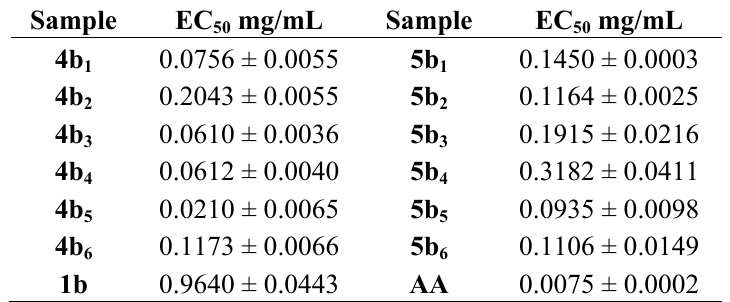
mg/mL) of the sulfisoxazole derivatives 4b 50